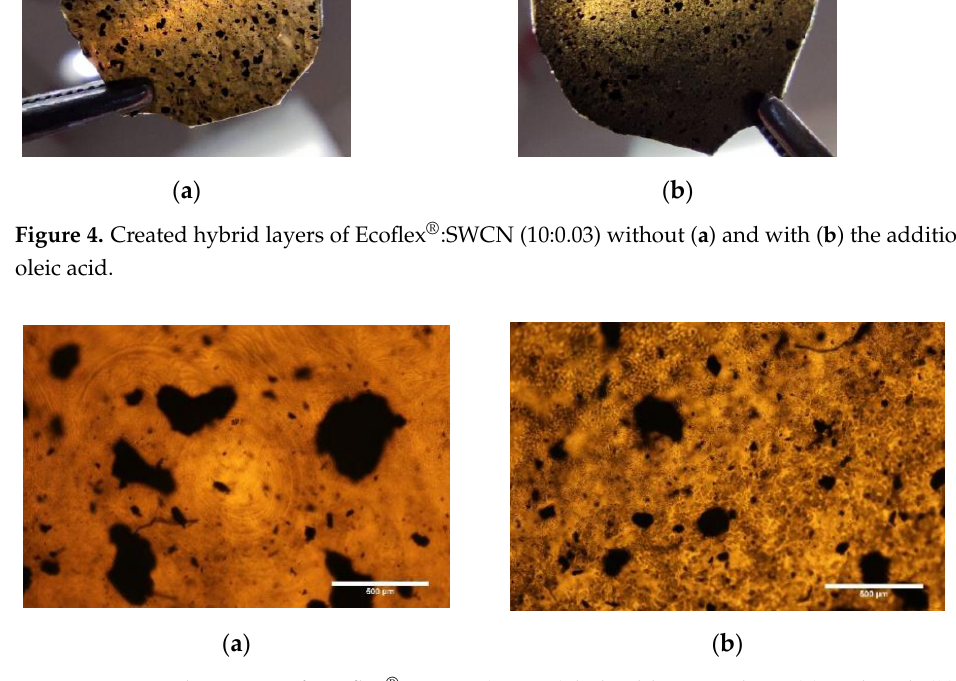
Figure 5. Optical textures of Ecoflex ® :SWCN (10:0.03) hybrid layer without ( a ) and with ( b ) the addition of oleic acid.